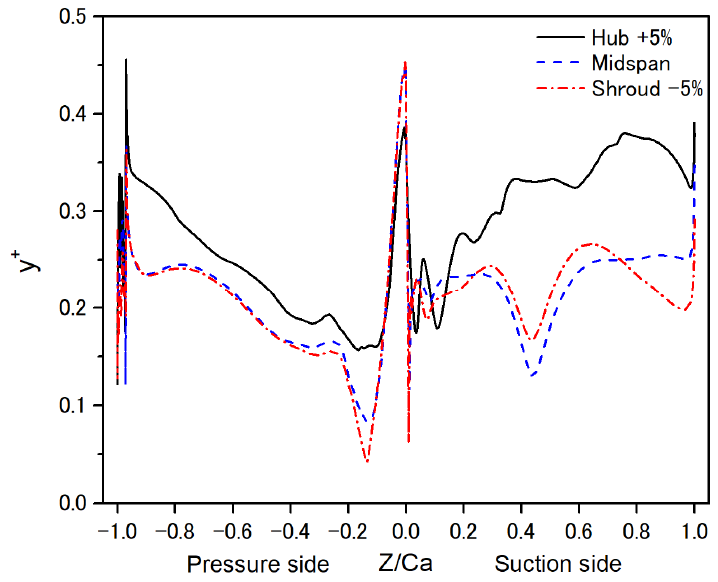
Figure 3. Variation in 𝑦 (cid:2878) at different span-wise locations in the rotor blade.